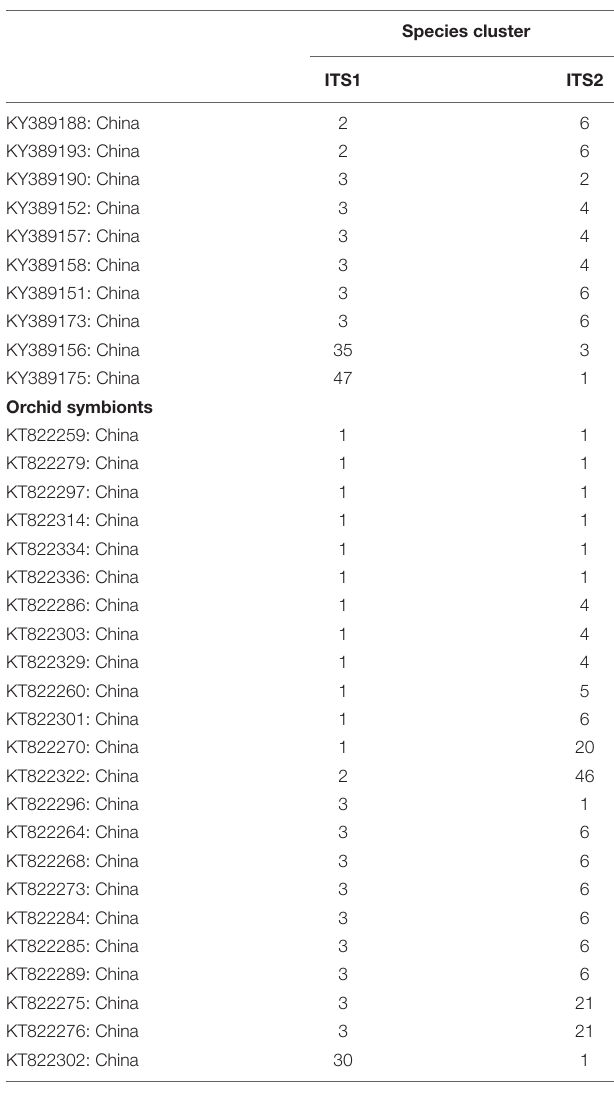
TABLE 1 | Armillarioid sequences (and corresponding GenBank accessions and location metadata) from tissue engaging in symbiotic associations.